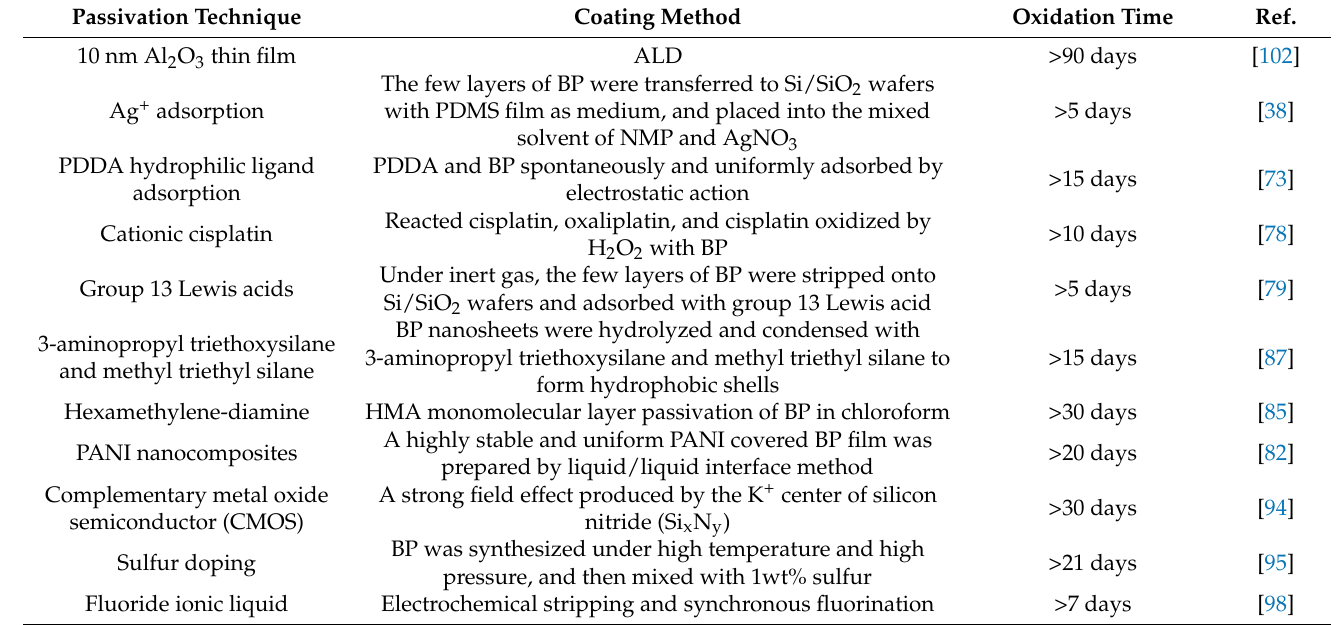
Table 2. Passivation method and effect comparison of 2D